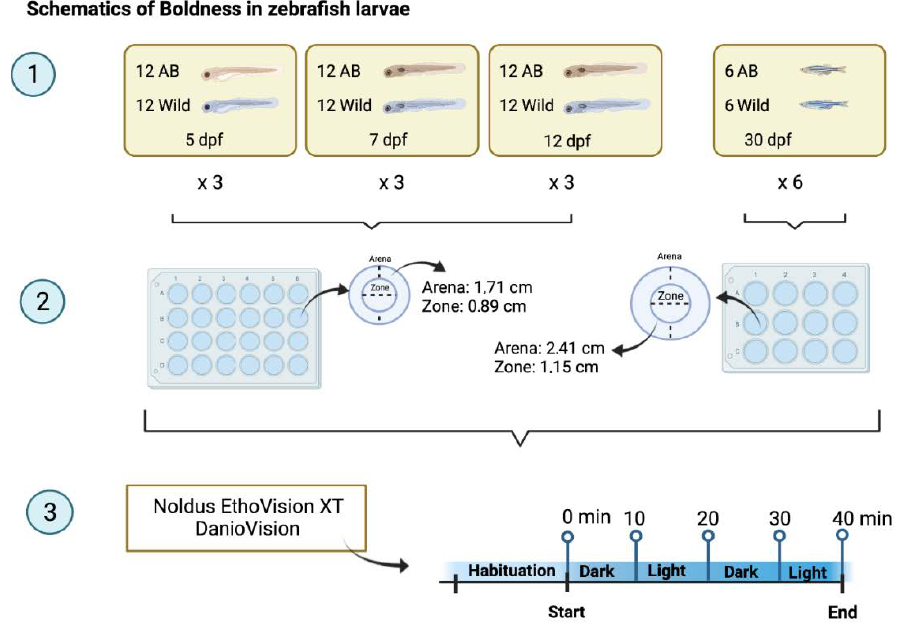
Figure 1. Schematics of the outline of the experiment. Created with BioRender.com.